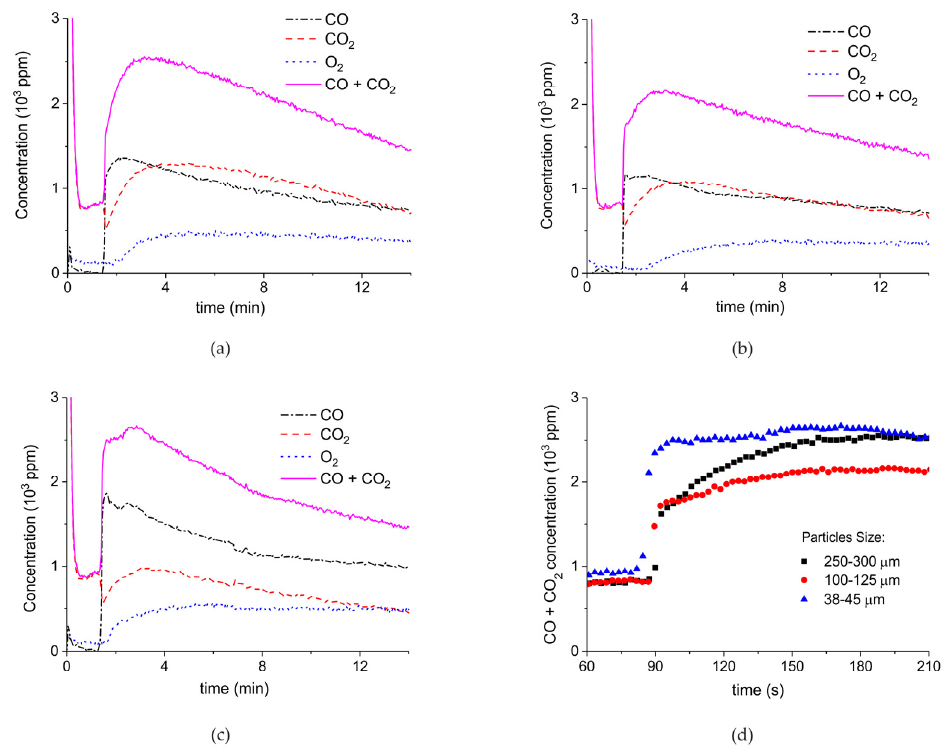
Figure 7. Concentration of the products of decomposition of sample C ( a ), sample D ( b ), and sample E ( c ) as function of time with a temperature of 630 °C in pure argon and flow rate of 30 mL/min; plasma power is 2.1 W for sample C, 1.3 W for sample D, and 1.7 W for sample E. ( d ) Initial response of CO + CO 2 concentration after activating the plasma for all three samples.